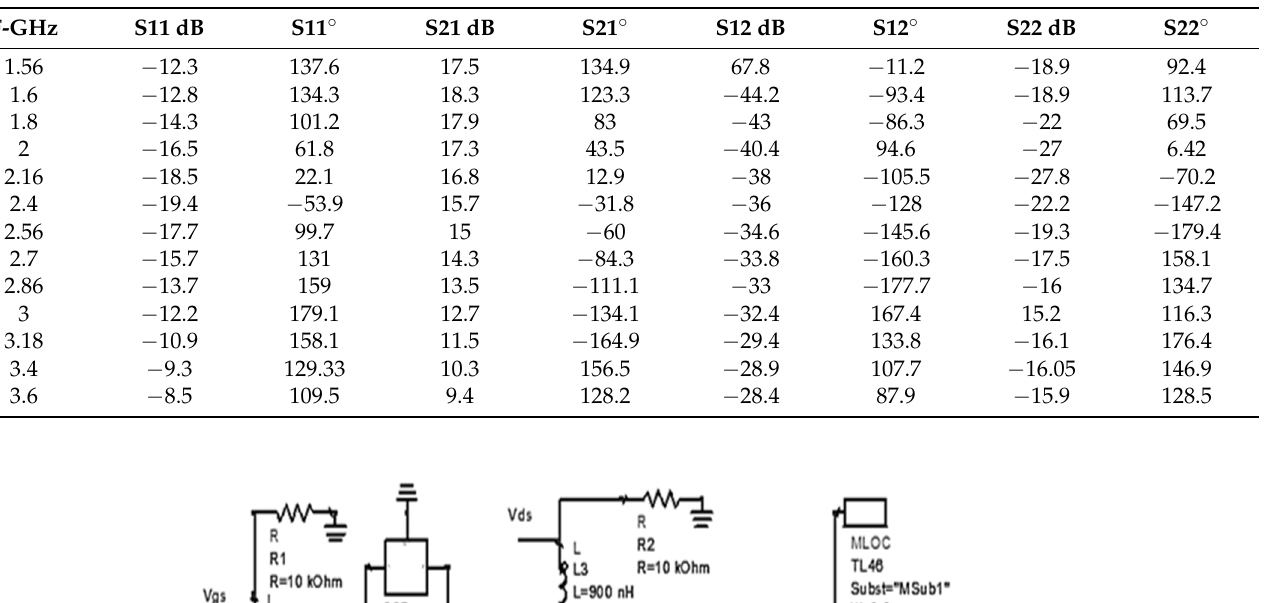
Table 8. S band High-power amplifier S parameters.